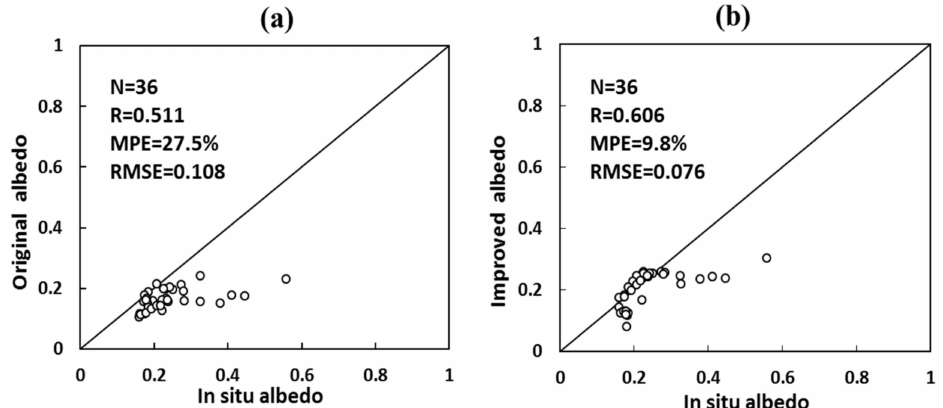
Figure 4. Comparison of statistical indexes between the original ( a ) and improved ( b ) albedo model at the ANNI station.